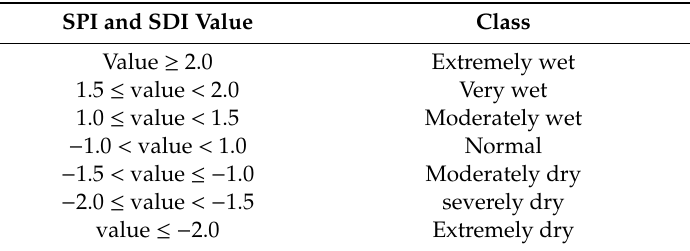
Table 1. Drought classes definition and their corresponding SPI (Standardized Precipitation Index) / Streamflow Drought Index (SDI)